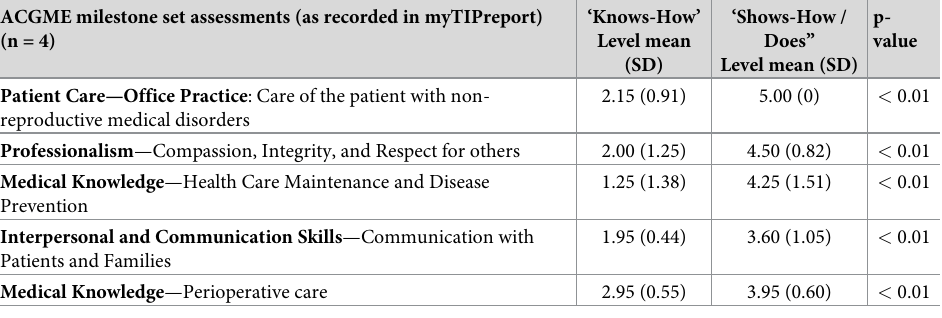
Table 4. Attending evaluations of milestone sets corresponding to SUD curriculum